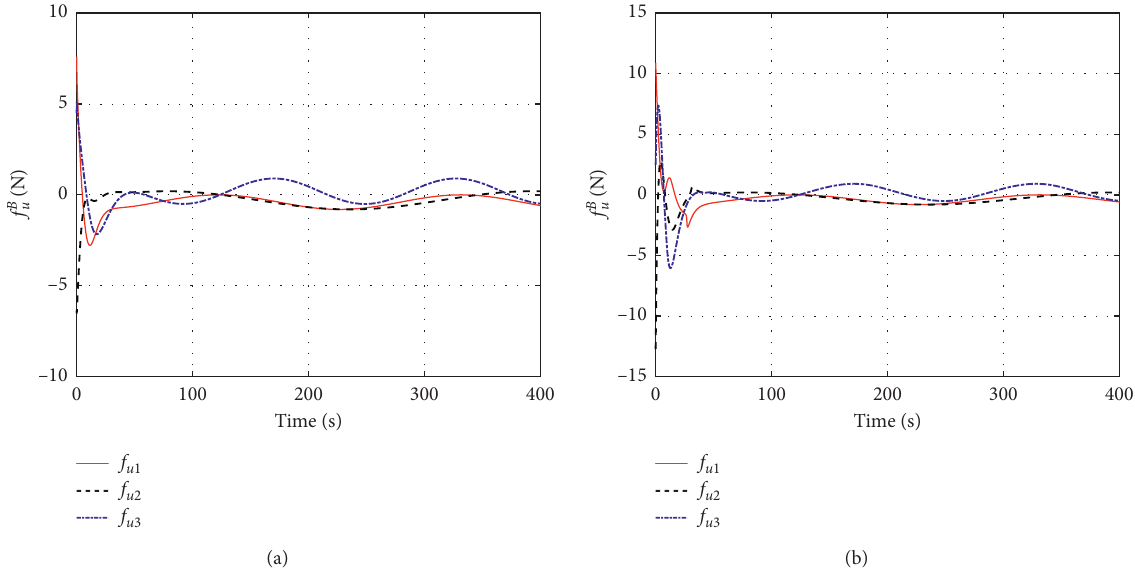
Figure 13: Control force. (a) Proposed I&I adaptive controller. (b)